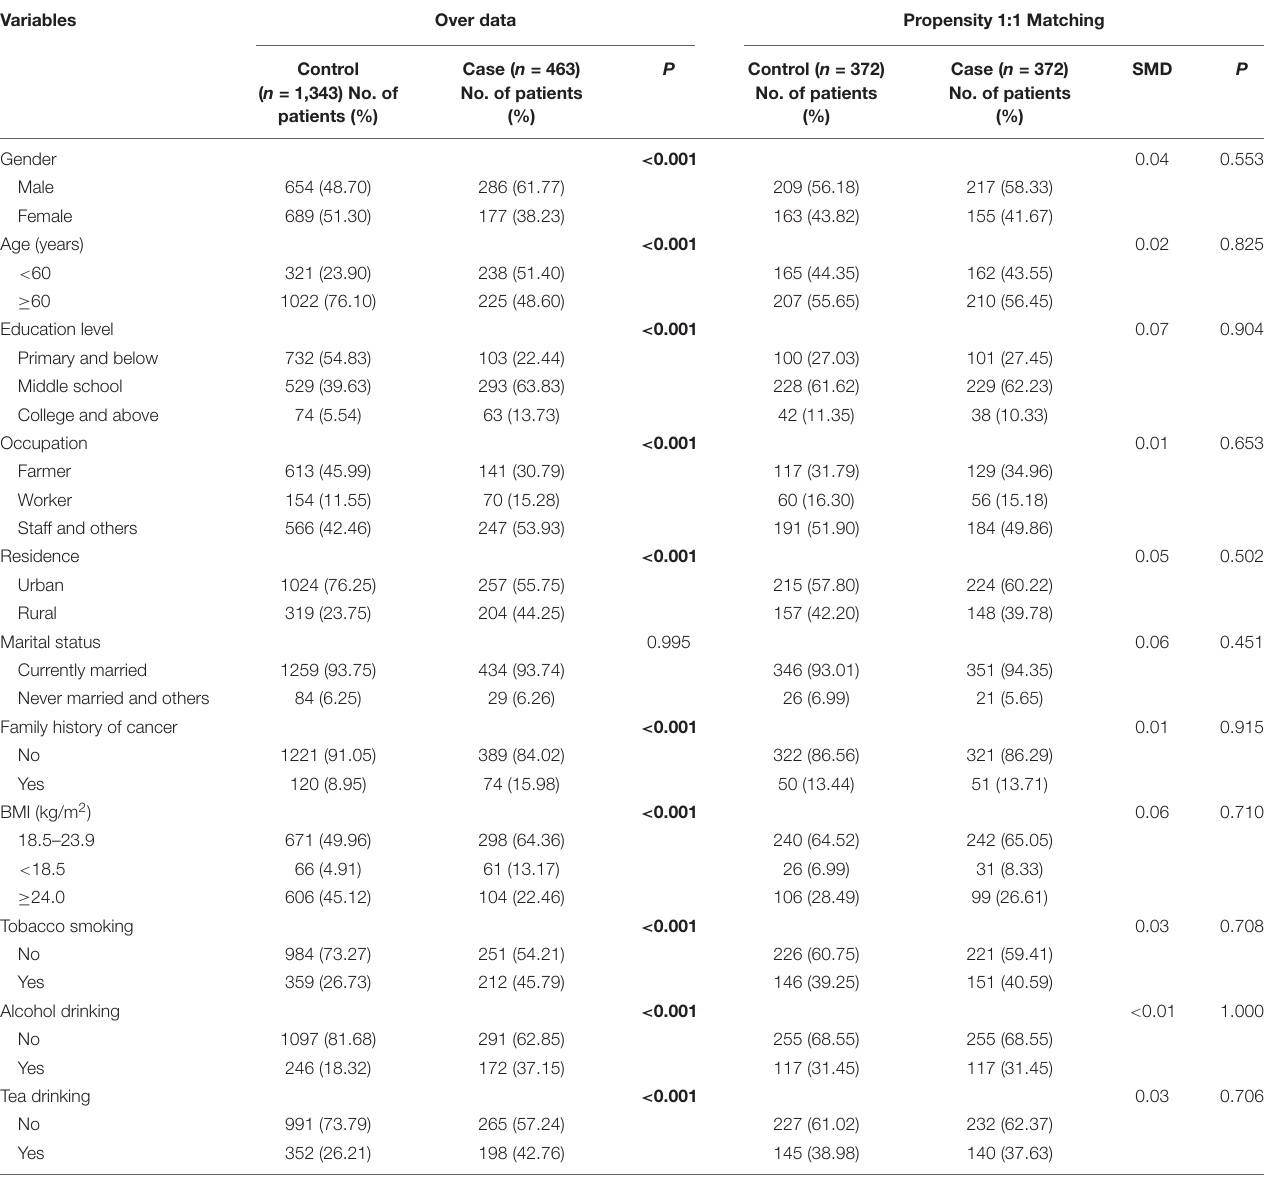
TABLE 1 | Baseline demographic characteristics of patients with oral cancer. Variables Over data Propensity 1:1